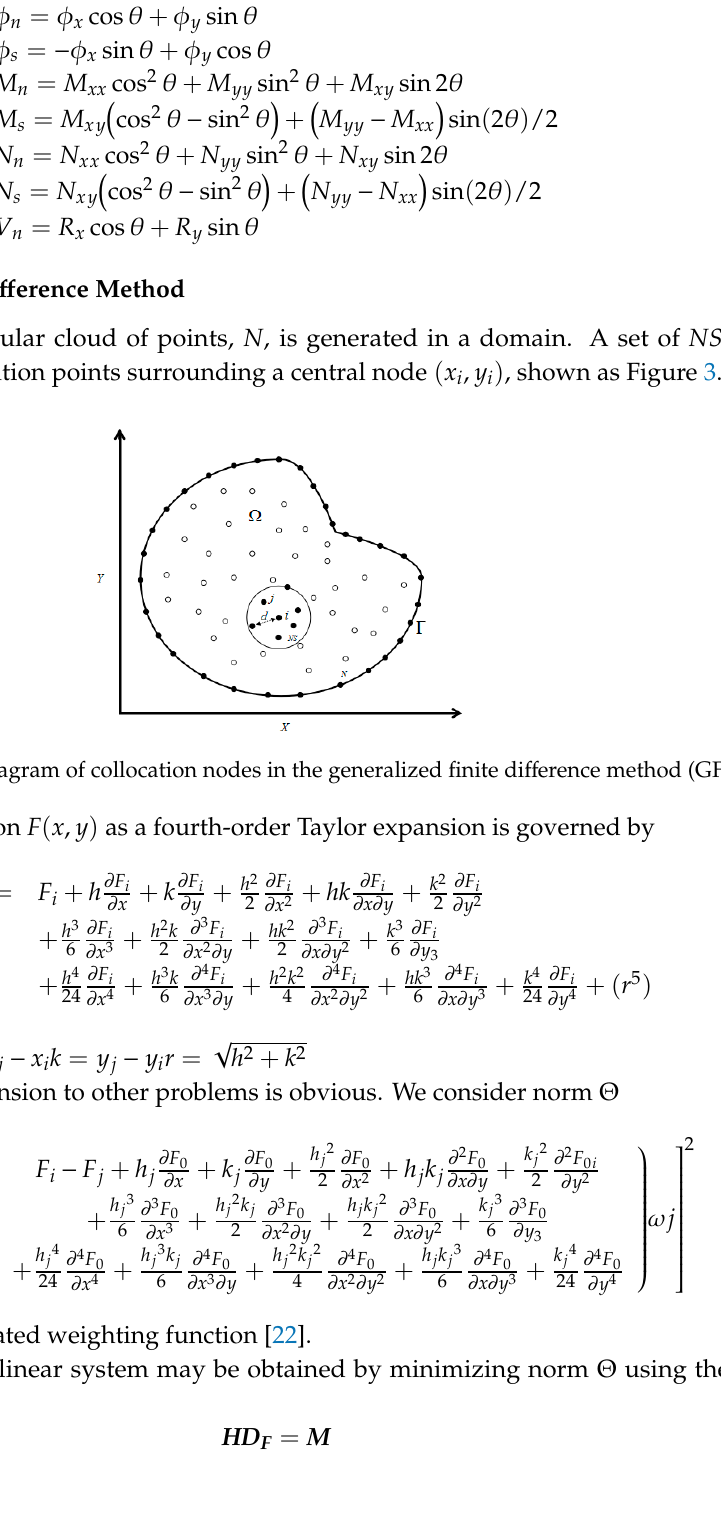
Figure 4. Clouds ( a ) 8 × 8 in a domain and ( b ) 12 × 12 in a domain.